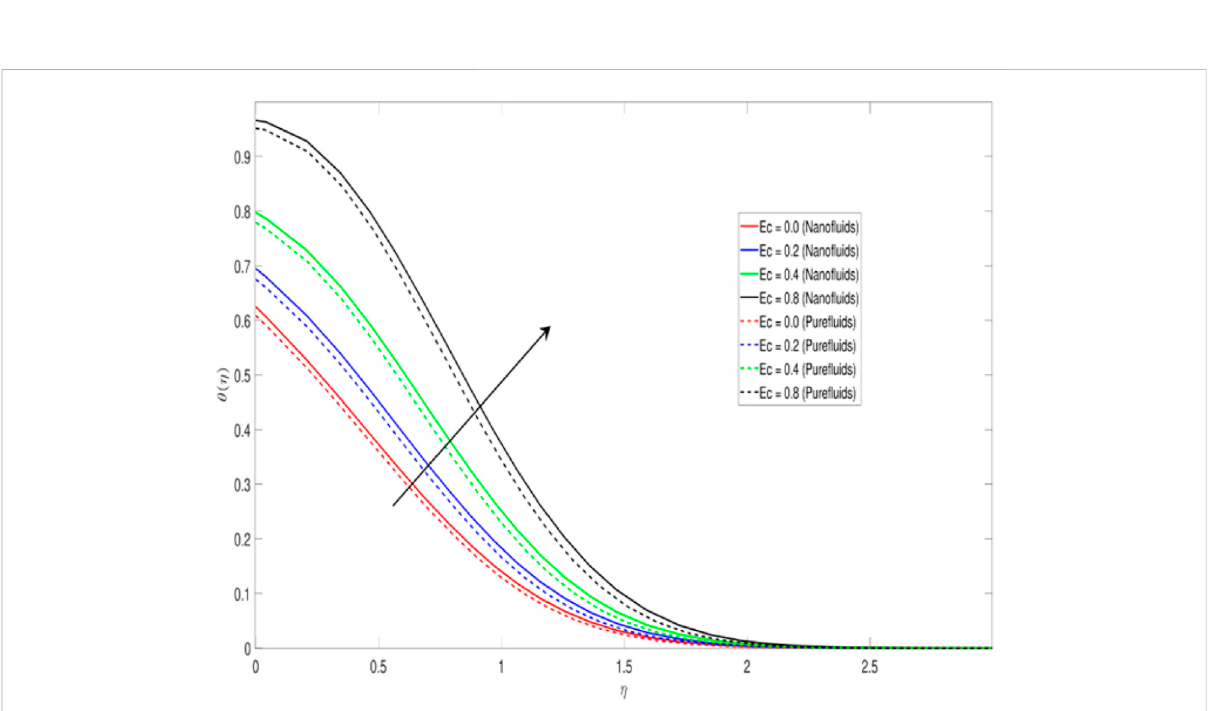
FIGURE 8 Temperature distribution vs. an Eckert number